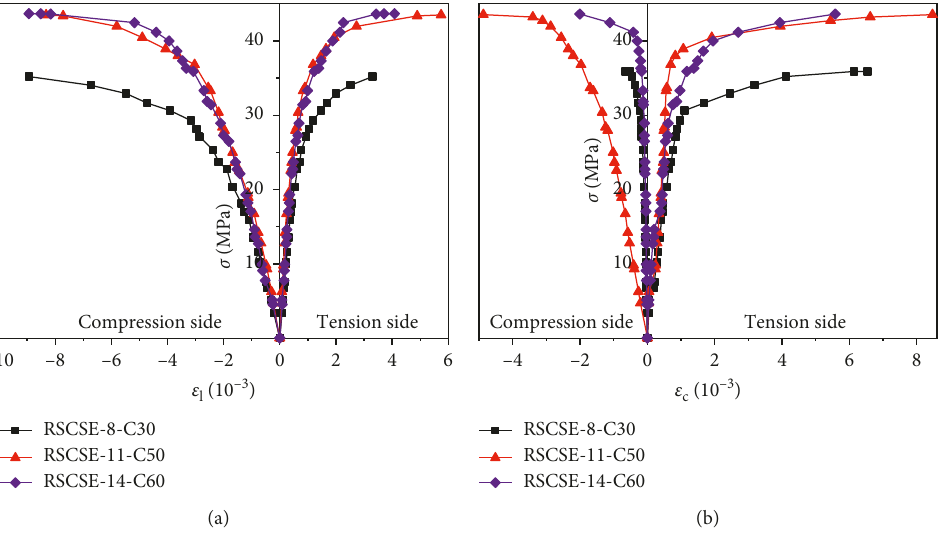
Figure 5: Effect of grade strength of concrete on the stress-strain curve ( e